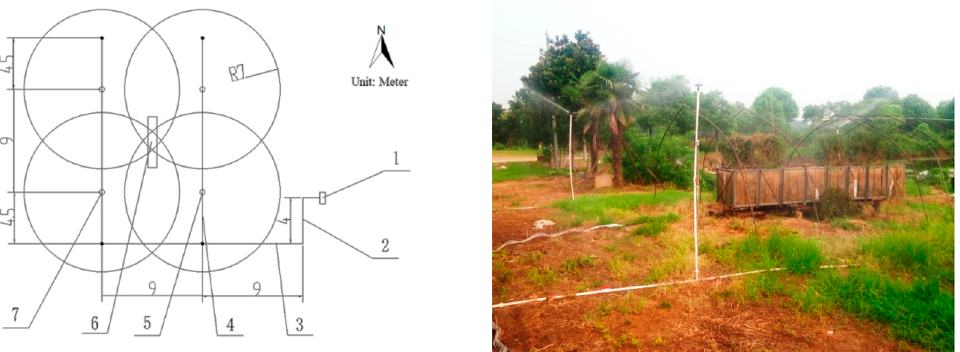
Figure 1. Box frame sprinkler irrigation system: 1—pump station; 2—main pipe; 3—distribution pipe; 4—lateral pipe; 5—standpipe; 6—box frame; 7—sprinkler.